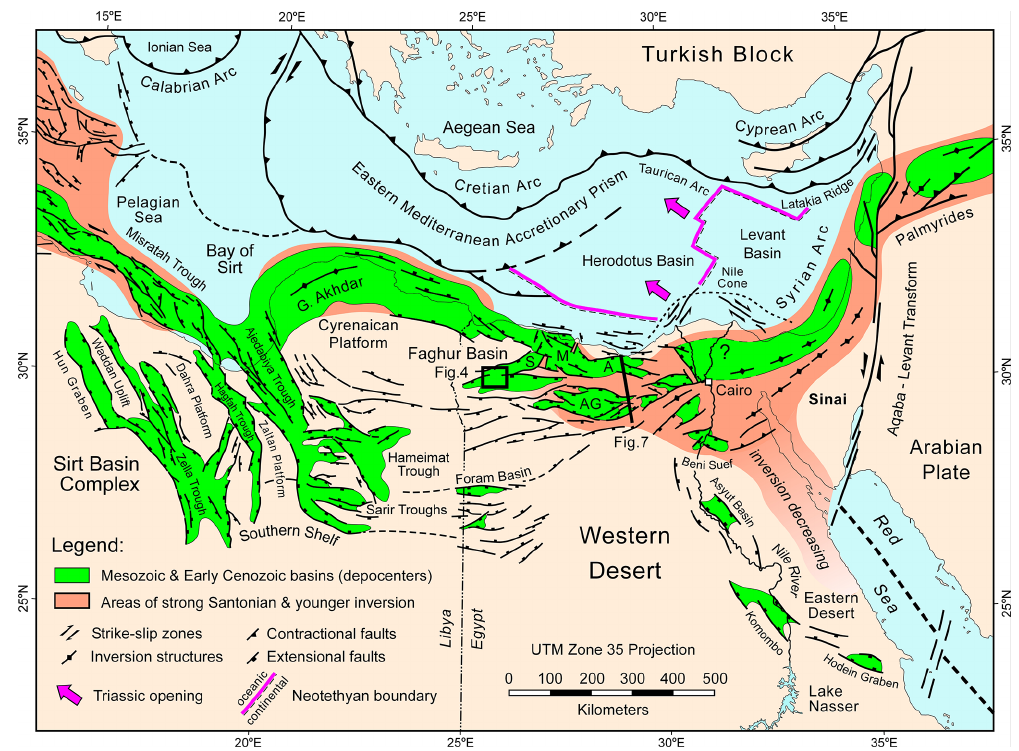
Figure 2. Egypt’s Western Desert and its regional geologic setting. Location is shown in Fig. 1. Box shows the location of Fig. 4 and the position of Fig. 7 is indicated. Increasingly milder inversion is observed moving south into the Gulf of Suez region. Similar trends are probably present in the Western Desert, but exposures of suitably aged rocks are generally lacking. A: Alamein basin; AG: Abu Gharadig basin; M: Matruh basin; S: Shushan basin. Triassic opening direction and Neotethyan oceanic–continental crustal boundary after Longacre et al. (2007). Plate boundaries (bold lines), basins, and regions of inversion from Bosworth et al. (2008) and references